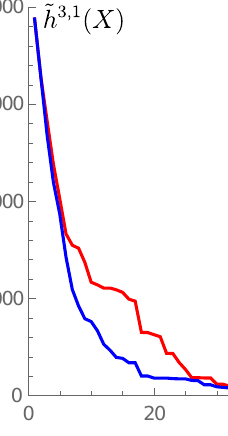
Figure 4 . The change in ~ h 3 ; 1 ( X ) as a function of h 1 ; 1 ( B ) for two random blow up sequences. The number of Weierstrass moduli drops